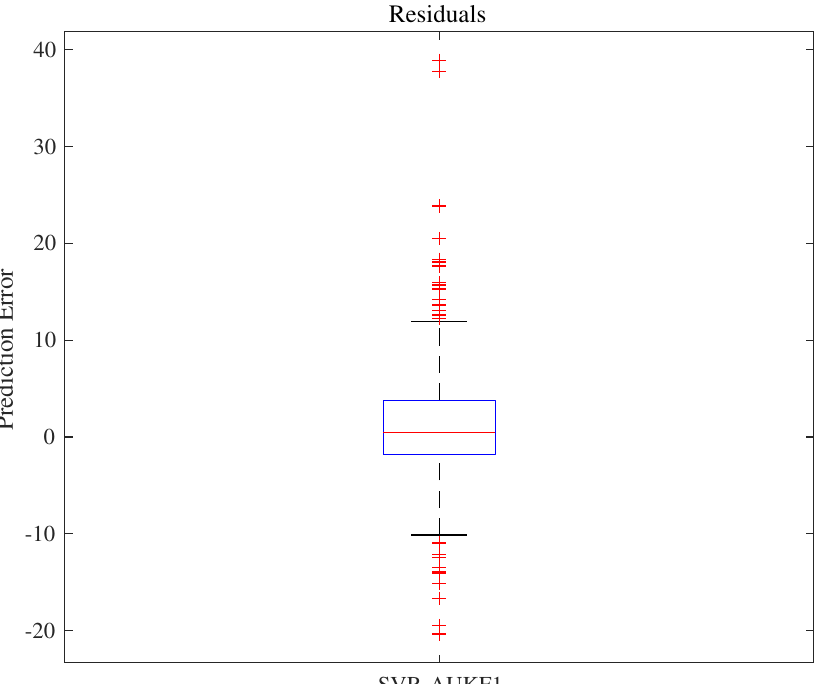
Figure 8. Boxplot of SVR-AUKF1 prediction